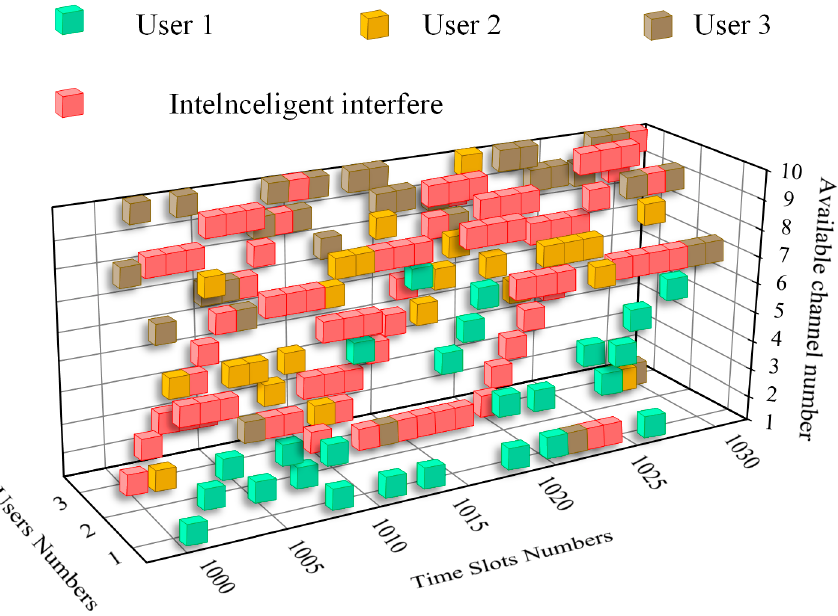
Figure 8. Schematic diagram of system channel selection-interference cubes in the middle of the iteration.